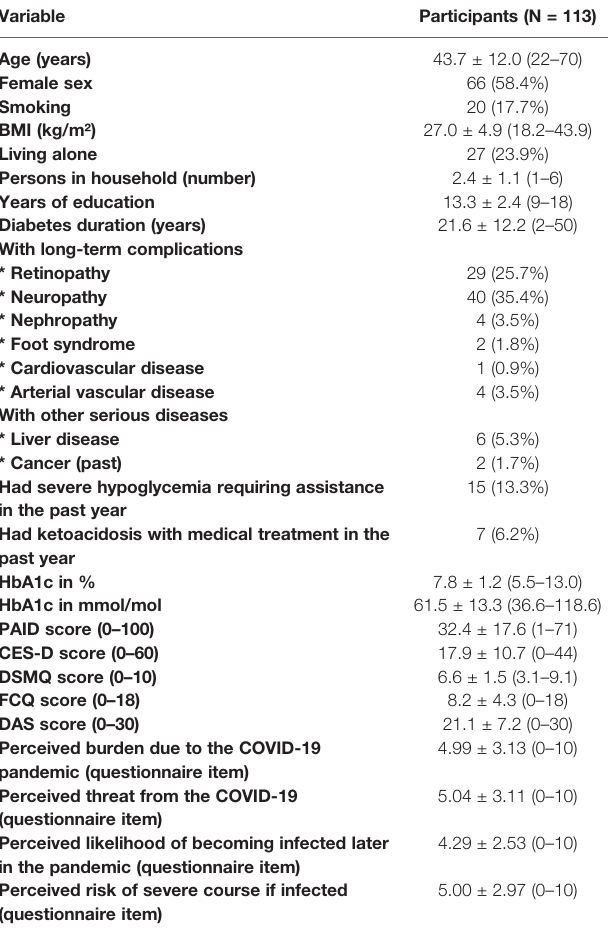
TABLE 1 | Characteristics of the study sample (at the time of the